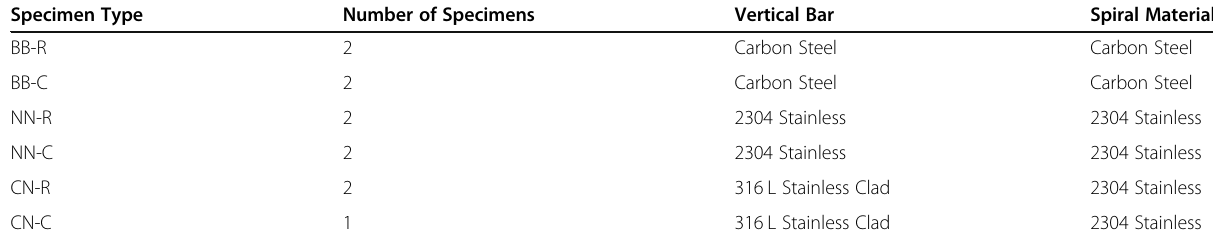
Table 2 Summary of specimen materials and dimensions Specimen Type